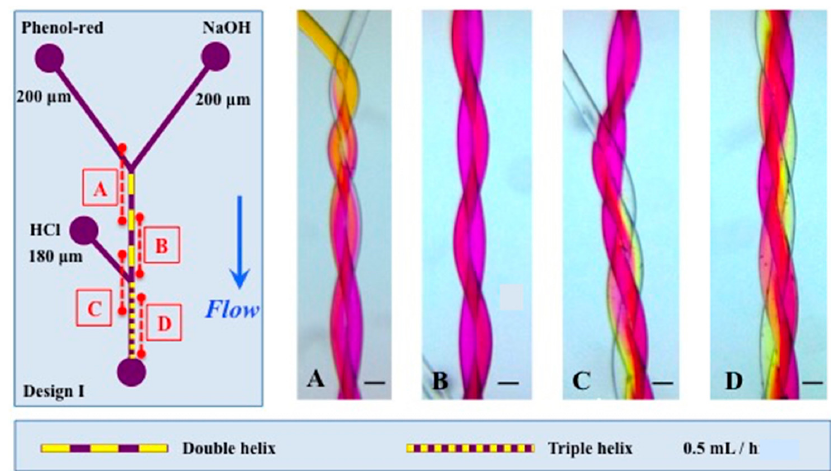
Figure 8. The left panel shows the design I, with the position of panels ( A – D ) along the channel. Channel lengths were 11 and 7 mm for the double and triple helix respectively. The channels of the double helix are 200 μ m and the channel entering in the triple helix is 180 μ m. The pitch length is 2.44 mm and 2.80 mm of the double and triple helix respectively. The scale represents 200 μ m. The flow used was 0.5 mL/h for Phenol-red (2 mM), HCl (2mM) and NaOH (2 mM).